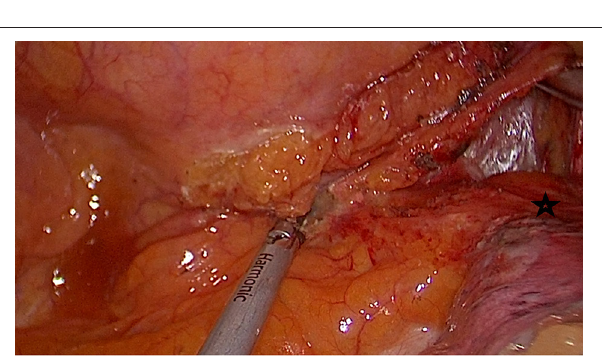
FIGURE 2 | Mobilization of the esophagus starts at the lower end. Pericardium (black star) posterior to the inferior pulmonary vein is the anterior plane for esophageal